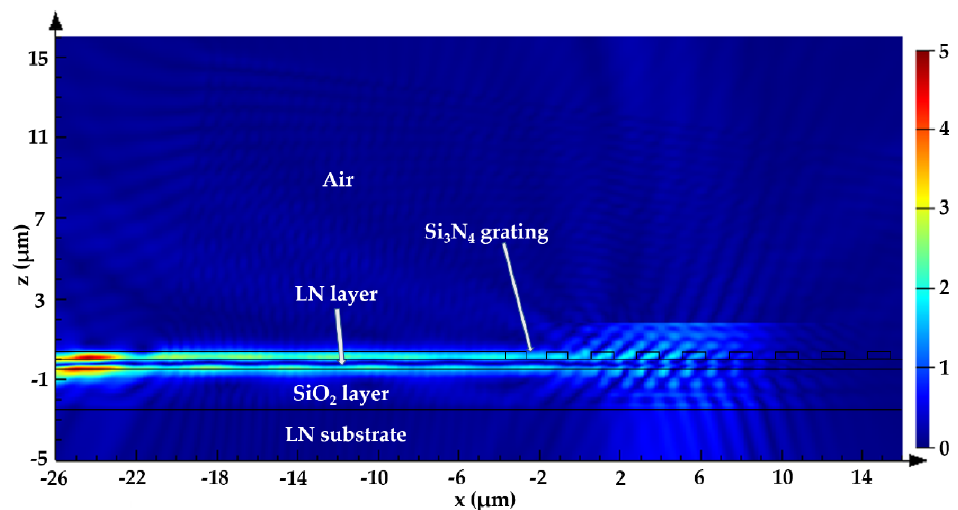
Figure 8. Electric field distribution of the light wave.